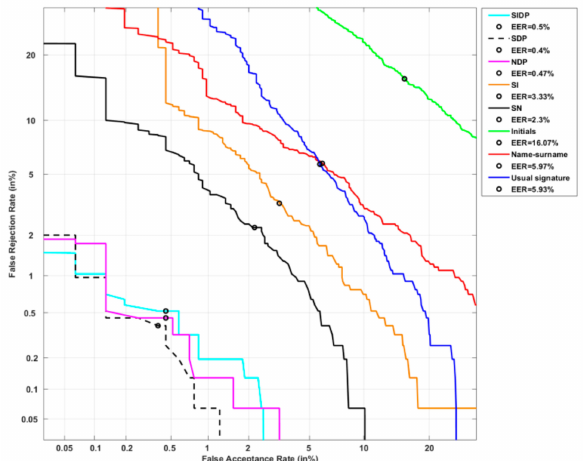
Figure 16. System performance on users of the medium PE category considering the 8 signature